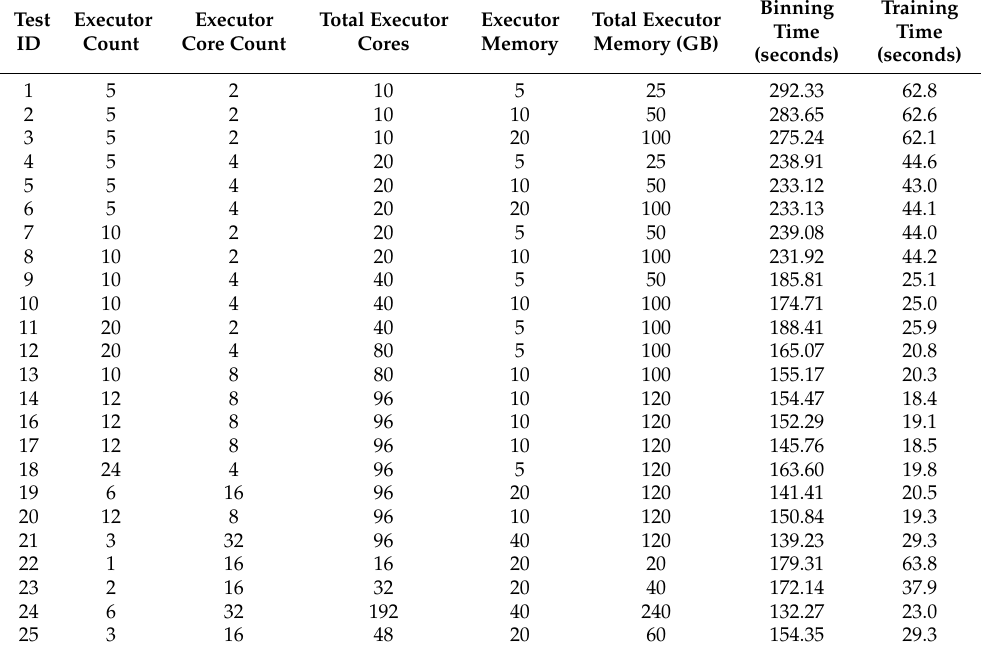
Table 15. Effect on binning and training time for Spark’s configuration parameters.